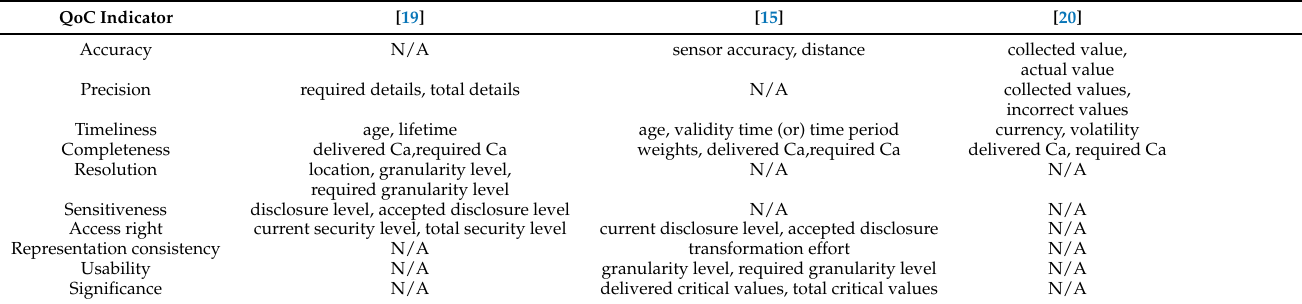
Table 6. QoC parameters used in different works, where the text in cells indicates the parameter(s) used by the work to compute the indicator in the respective row. The “N/A” shows that the work in the respective column has not considered the indicator in the respective row. “Ca” indicates “context